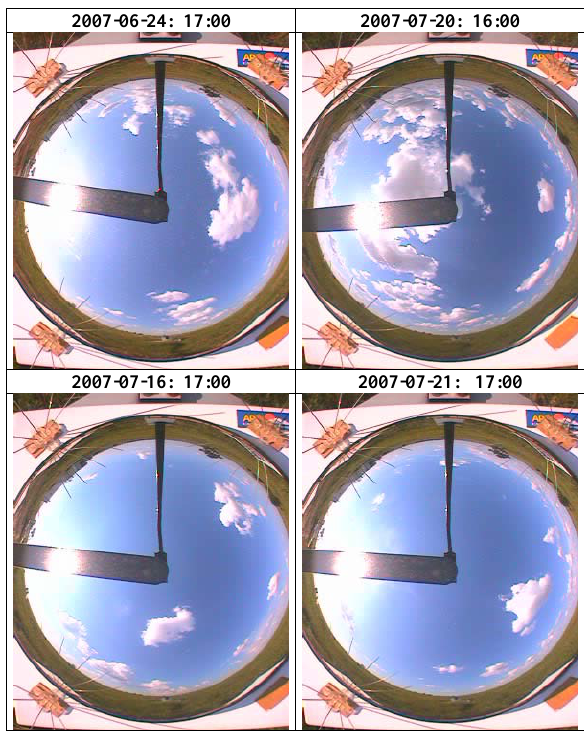
Fig. 3b . Hemispherical total sky images for the last 4 days in Fig. 2.